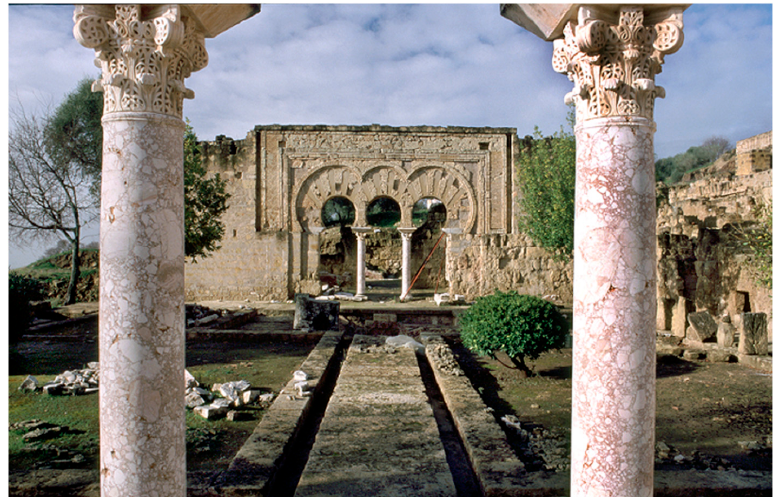
Figure 8. House of the Pool. Courtyard-garden and interior façades. (Photo M. Pijuán © Conjunto Arqueológico de Madinat al-Zahra).